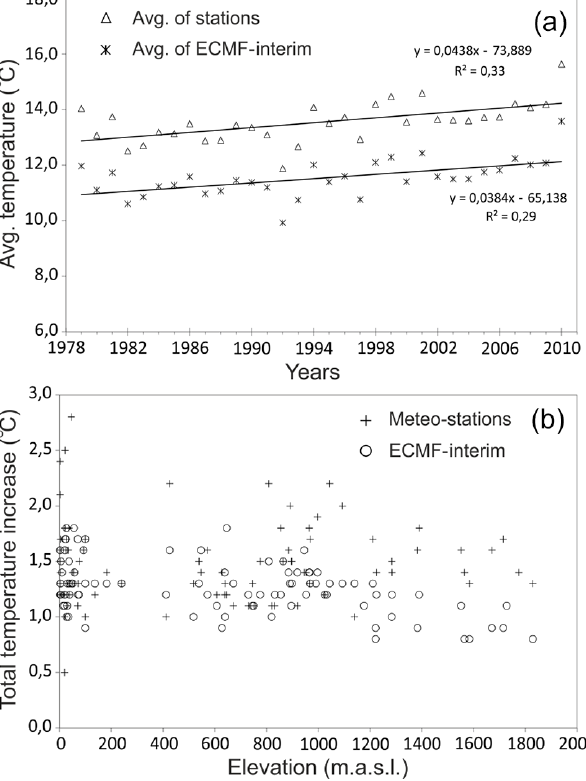
Figure 3. (a) The comparison of the average yearly temperature between (all) the stations (shown in Fig. 2) and the corresponding grids from the ERA-Interim dataset. (b) The comparison of the total 32-year increase in temperatures by the meteo-stations and the cor- responding grids from the ERA-Interim with respect to